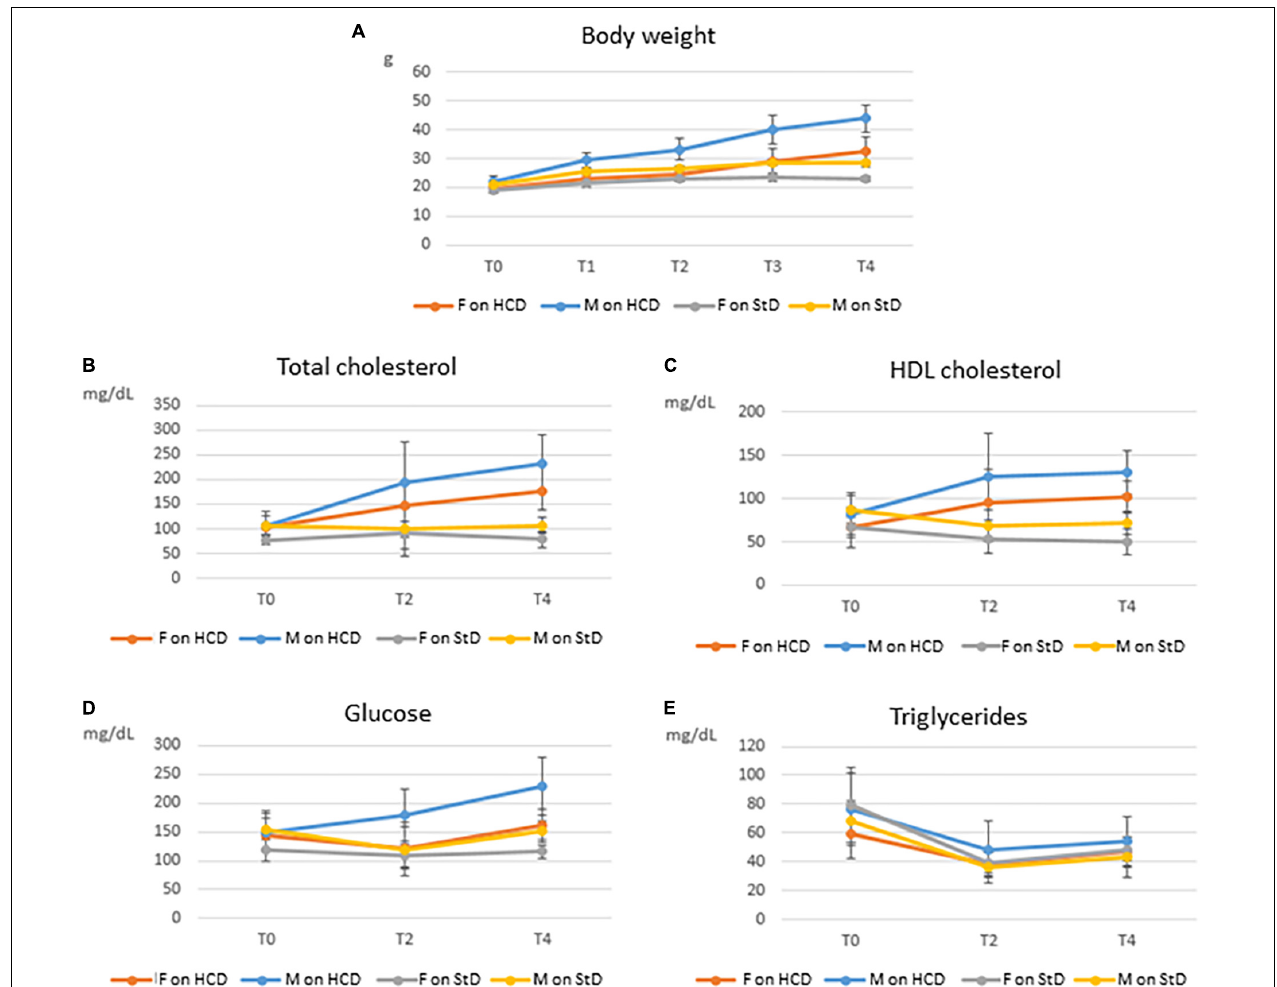
FIGURE 2 | Trends in body weight and blood biochemistry among C57BL/6 mice over 4 months on HCD (the MetS induction phase) or StD, by gender. Means and SDs of body weight (A) , total cholesterol (B) , high-density lipoprotein (HDL) cholesterol (C) , glucose (D) , and triglycerides (E) for both male (M) and female (F) mice on high-calorie diet (HCD) or standard diet (StD), before (T0) and after 1 (T1), 2 (T2), 3 (T3), and 4 (T4) months feeding on HCD or